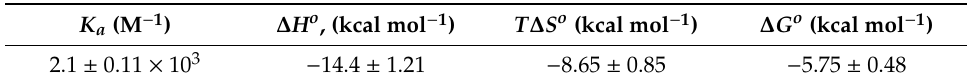
Figure 2. ITC isotherm of 2,4-TZD / HSA binding. The upper panel shows heat changes that took place during each injection. The lower panel demonstrates the changes in energy that took place per injection as a function of 2,4-TZD to HSA molar ratio. Table 2. Binding and thermodynamic parameters obtained by isothermal calorimetric titration of 2,4-TZD with HSA at 298 K. Values are means of triplicates ± SD.